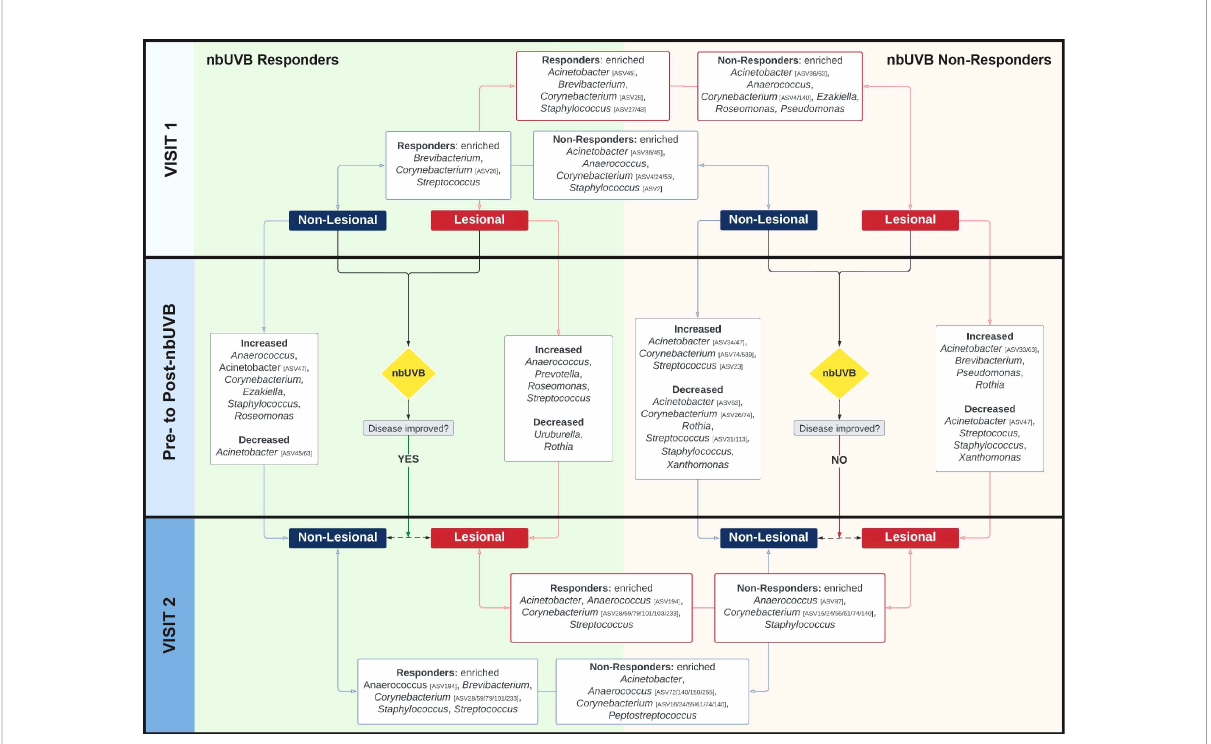
FIGURE 4 The skin microbiome changes after exposure to nbUVB phototherapy, as demonstrated by shifts at the taxonomic level of genus. Map of genus- level taxa abundances differentiating responders (R) and non-responders (NR) at lesional and non-lesional sites. Panels represent speci fi c analyses: pre-nbUVB (top panel), pre- versus post-nbUVB (middle panel), and post-nbUVB (bottom panel). In cases of mixed responses at the genus level, speci fi c ASVs identi fi ed on differential analysis are noted. Bidirectional arrows indicate the skin sites being compared at the same time point (e.g., R/lesional skin/pre-nbUVB versus NR/lesional skin/pre-nbUVB); unidirectional arrows indicate longitudinal shifts (e.g., R/lesional skin/pre-nbUVB versus R/lesional